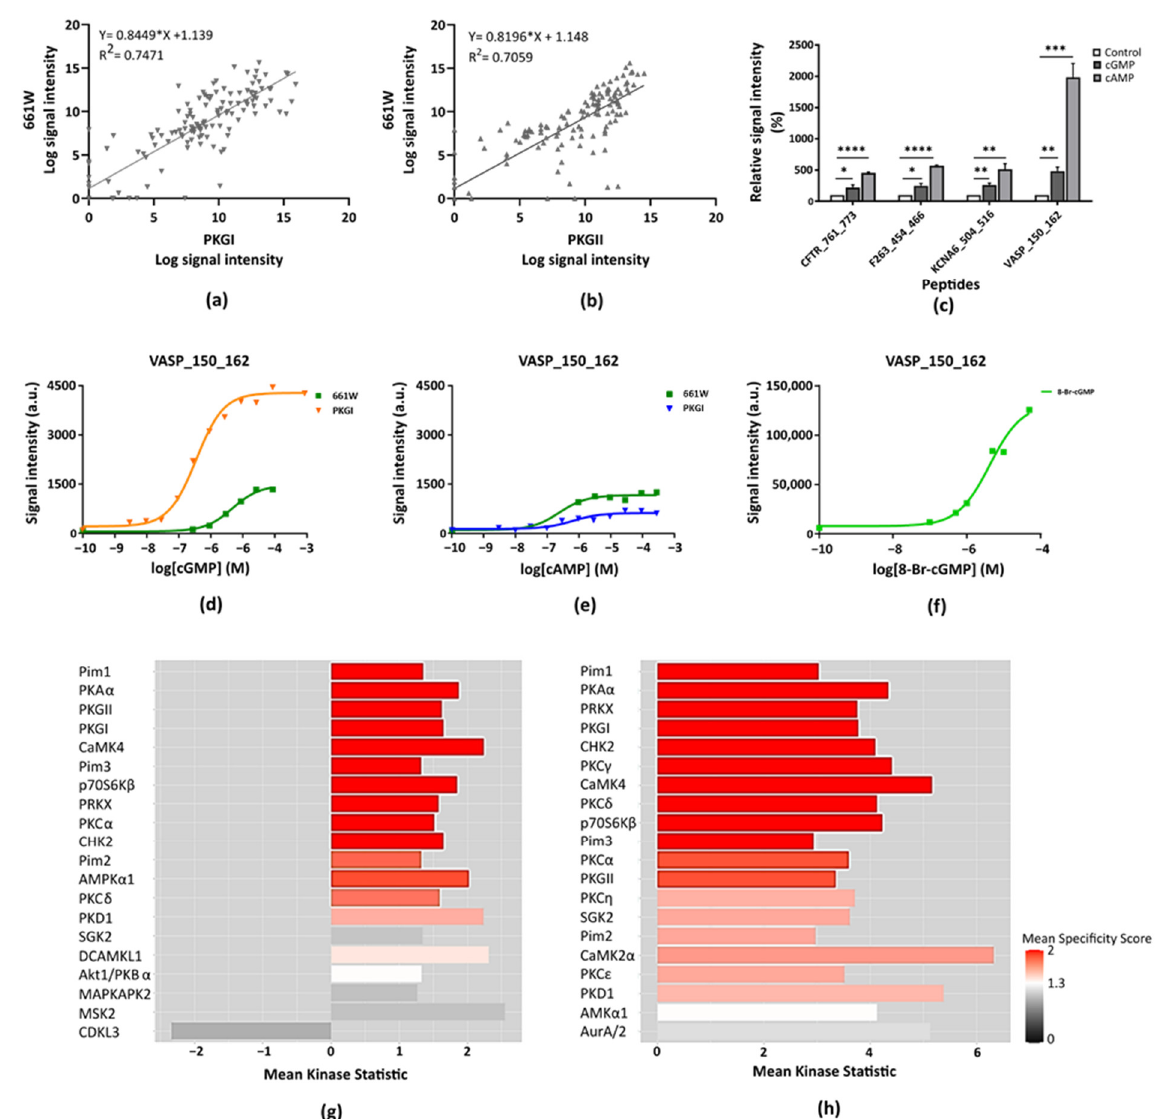
Figure 3. ( a , b ) Scatter plot of signal intensities of 661W cell lysate and the recombinant kinases PKGI ( a ) and PKGII ( b ) at 100 µM cGMP. ( c ) Modulation of kinase activity by 1 µM cGMP and cAMP in 661W cell lysate for selected peptides. Relative signal intensity was measured in triplicate and expressed with respect to the condition without the modulator. The significance of changes with cGMP and cAMPs was determined by Unpaired T -test with significance indicated as * ( p ≤ 0.05), ** ( p ≤ 0.01) and *** ( p ≤ 0.001), **** ( p ≤ 0.0001). ( d , e ) Modulation of phosphorylation of the peptide VASP_150_162 for recombinant PKGI and 661W cell lysate with an increase in cGMP ( d ) and cAMP ( e ) concentrations. The relative signal intensity of VASP_150_162 is plotted against log concentration of cGMP (left) or cAMP (right). Data points are the mean of three replicates. ( f ) Modulation of kinase activity for peptide VASP_150_162 in 661W cell lysate with increasing concentrations of PKG Activator 8-Br-cGMP (n = 1). ( g , h ) Kinases predicted by upstream kinase analysis to be activated in 661Wcells at 1 µ M cGMP ( g ) or cAMP ( h